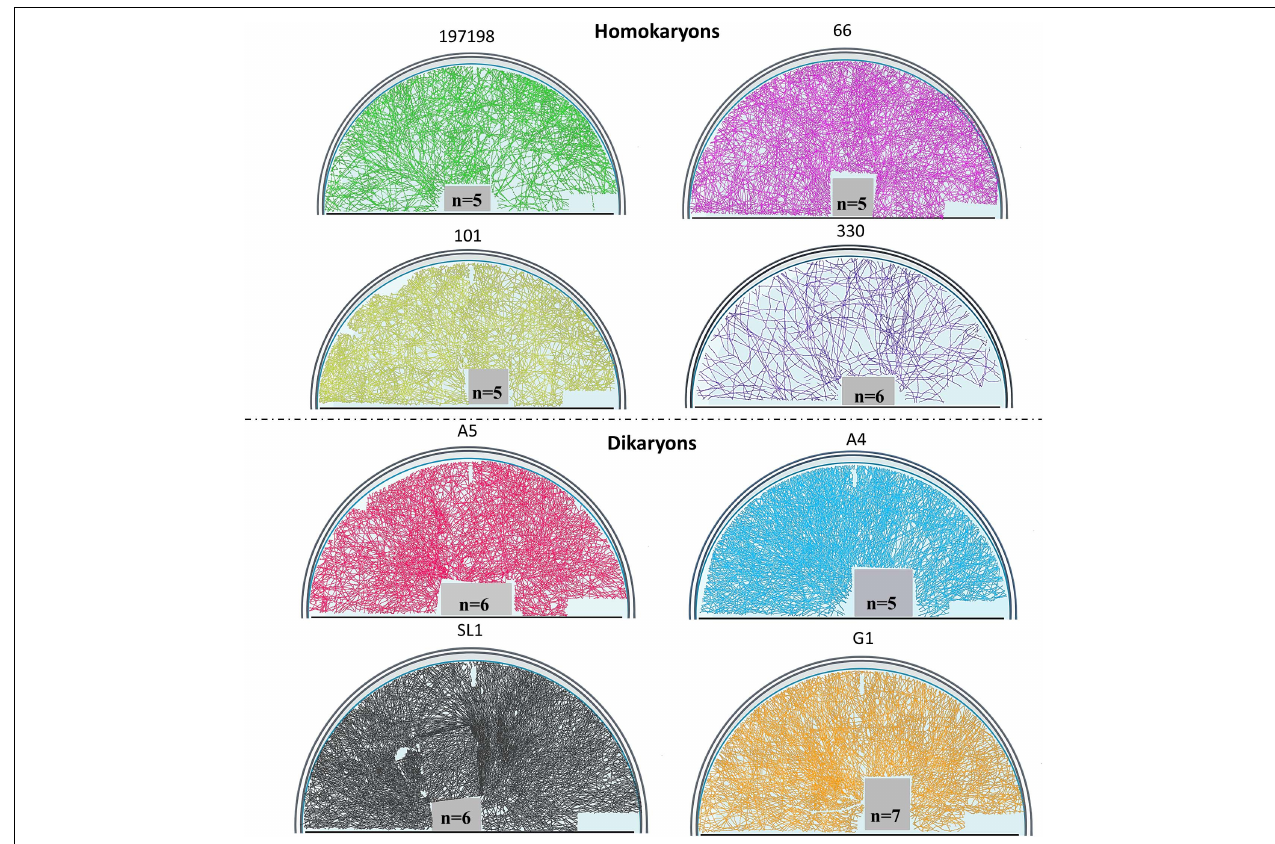
FIGURE 2 | Symbiotic hyphal growth of four homokaryotic and four dikaryotic strains in Daucus carota root organ culture as a host. The images demonstrate the actual hyphal growth per strain 30 days after the hyphae crossed to the hyphal compartment of the Petri dish. The bridge and the lower right part of the Petri dish appear empty since hyphal growth could not be accessed as it was concealed by either the bridge or by the blurred part of the Petri dish (manufacturers feature). To correct for size variation of the filter bridge between plates, an area was removed from each image prior to determination of the hyphal traits. Although multiple plate replicates were analyzed per strain ( n number visible in each plate), we chose to demonstrate one representative plate per strain.